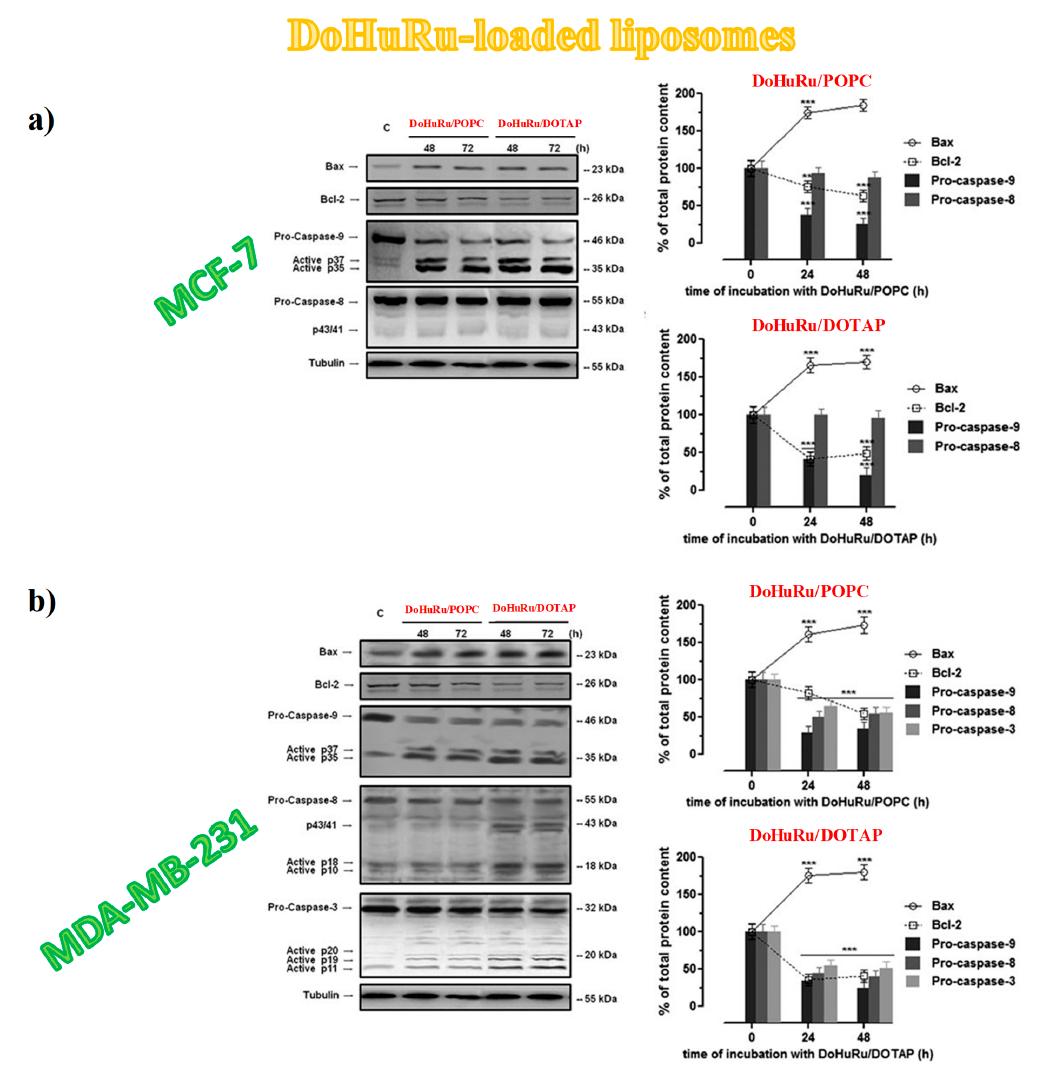
Figure 13. Western blot analysis showing the e ff ects of IC 50 doses of DoHuRu / POPC and DoHuRu / DOTAP following 48 and 72 h of incubation in MCF-7 ( a ) and MDA-MB-231 ( b ) cells on caspases-3, -8 and -9 expression and activation, and on Bax and BCL-2 expression. Bands resulting after chemoluminescence from treated cells were extracted, quantified by densitometric analysis and then plotted (graphs on the right of each panel): solid and dotted lines for Bax and BCL-2 expression proteins, respectively, and bar graphs (caspases-3, -8 and -9) reported as percentage of control in relation to the used Ru-containing nanoaggregates. Figures are adapted from [134].